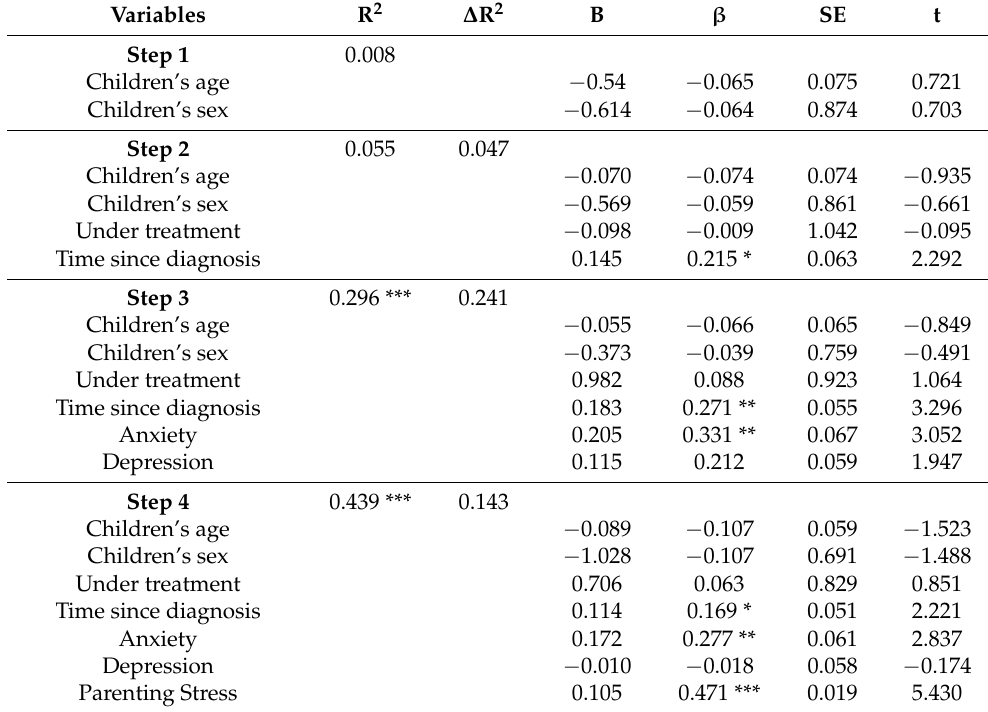
Table 2. Regression analysis for children’s difficulties (dependent